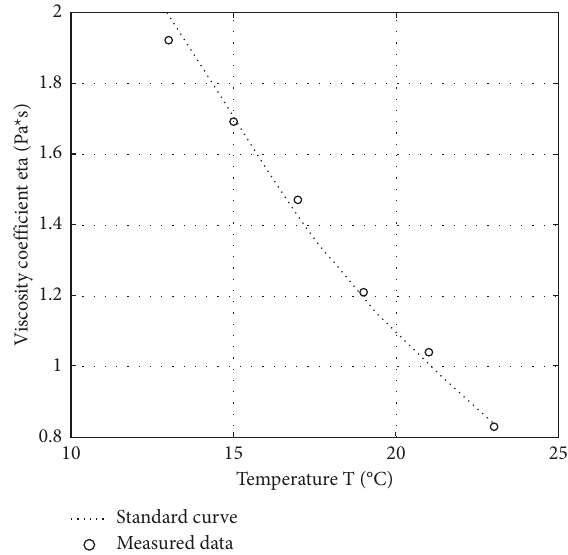
Figure 5: The viscosity coefficient of castor oil changes with